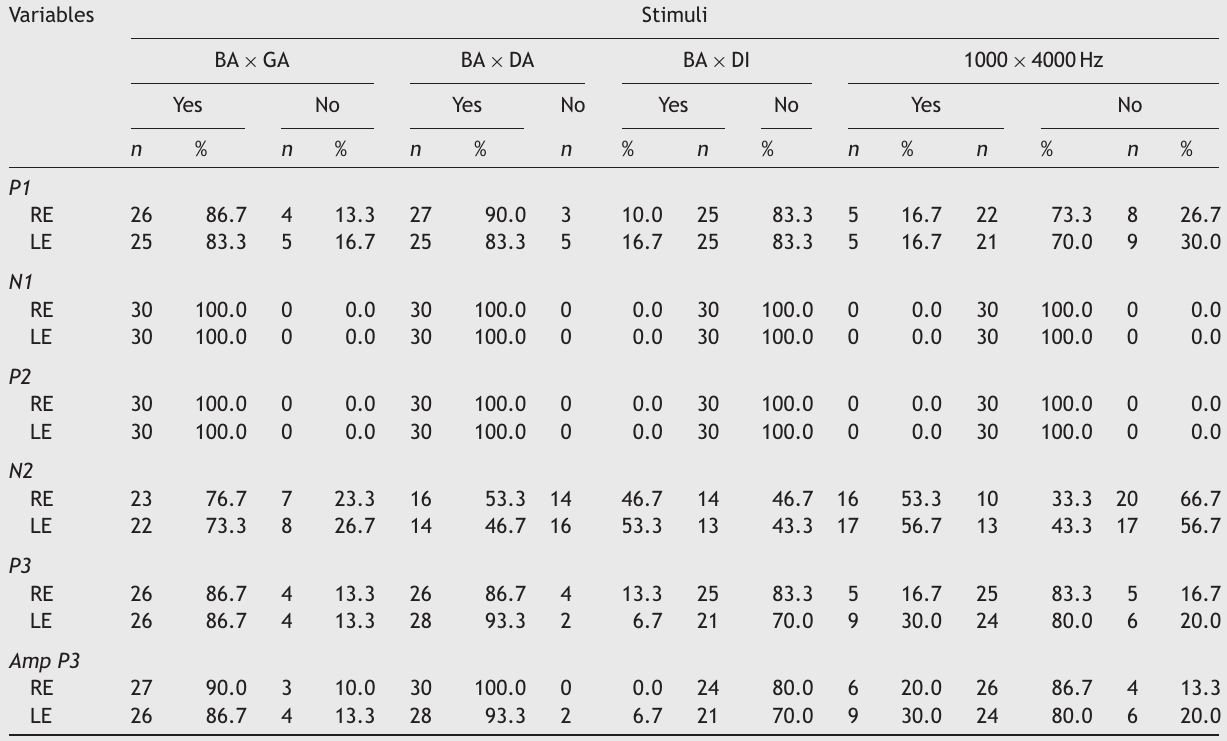
Table 2 Absolute distribution and relative to the presence and absence of information on the data for components P1, N1, P2, and N2 with all speech stimuli (BA---GA/BA---DA/BA---DI) and tone burst (1000 Hz × 4000 Hz).